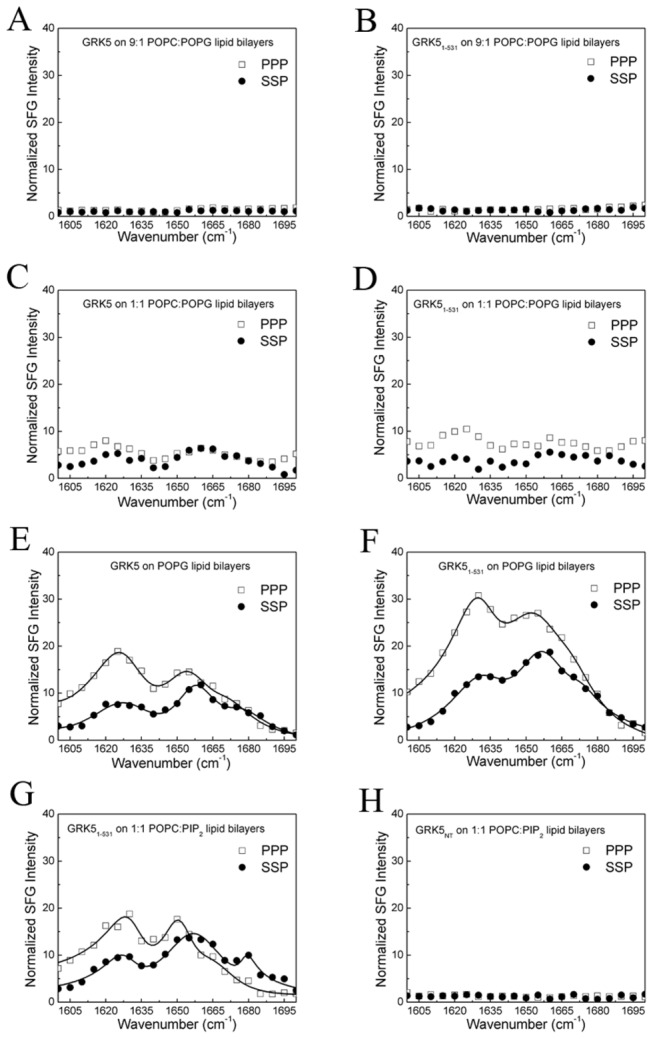
SFG signal of GRK5 and GRK51-531.No discernible SFG amide I signals were observed for 336 nM (A) GRK5 and (B) GRK51-531 interacting with a 9:1 POPC:POPG lipid bilayer. SFG polarized amide I signals of 336 nM (C) GRK5 and (D) GRK51-531 interacting with a 1:1 POPC:POPG lipid bilayer. SFG polarized amide I signals of 336 nM (E) GRK5 and (F) GRK51-531 interacting with a POPG lipid bilayer. SFG polarized amide I signal of 336 nM (G) GRK51-531 and (F) GRK5NT interacting with a 1:1 POPC:PIP2 lipid bilayer. The circles and squares are experimental data. The solid lines indicate the fitting results.